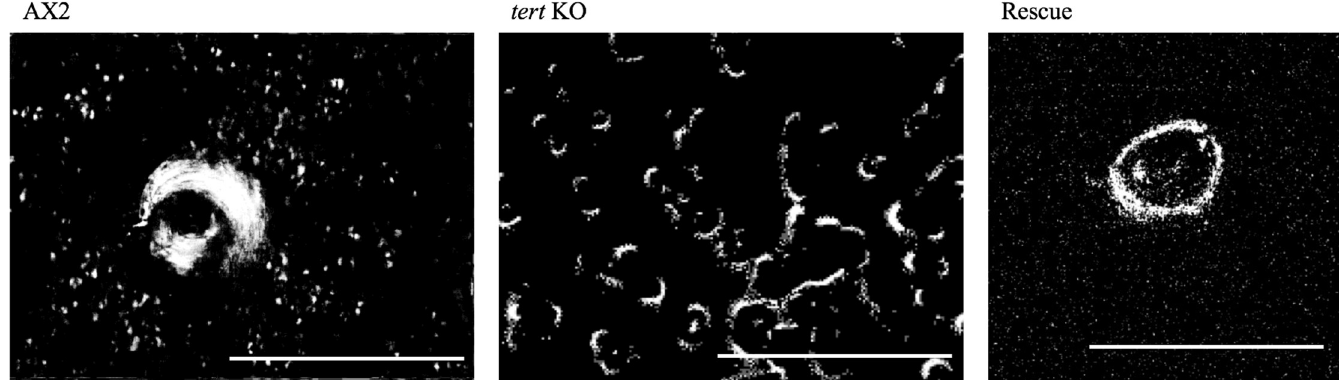
Fig 8. cAMP wave generating centres. Optical density wave images depicting wave generating centres in AX2, tert KO and a rescue strain are shown. AX2 and the rescue strain have a single wave generating centre, whereas tert KO has multiple wave generating centres in a single aggregate territory. Scale bar: 1 mm; (n = 3).